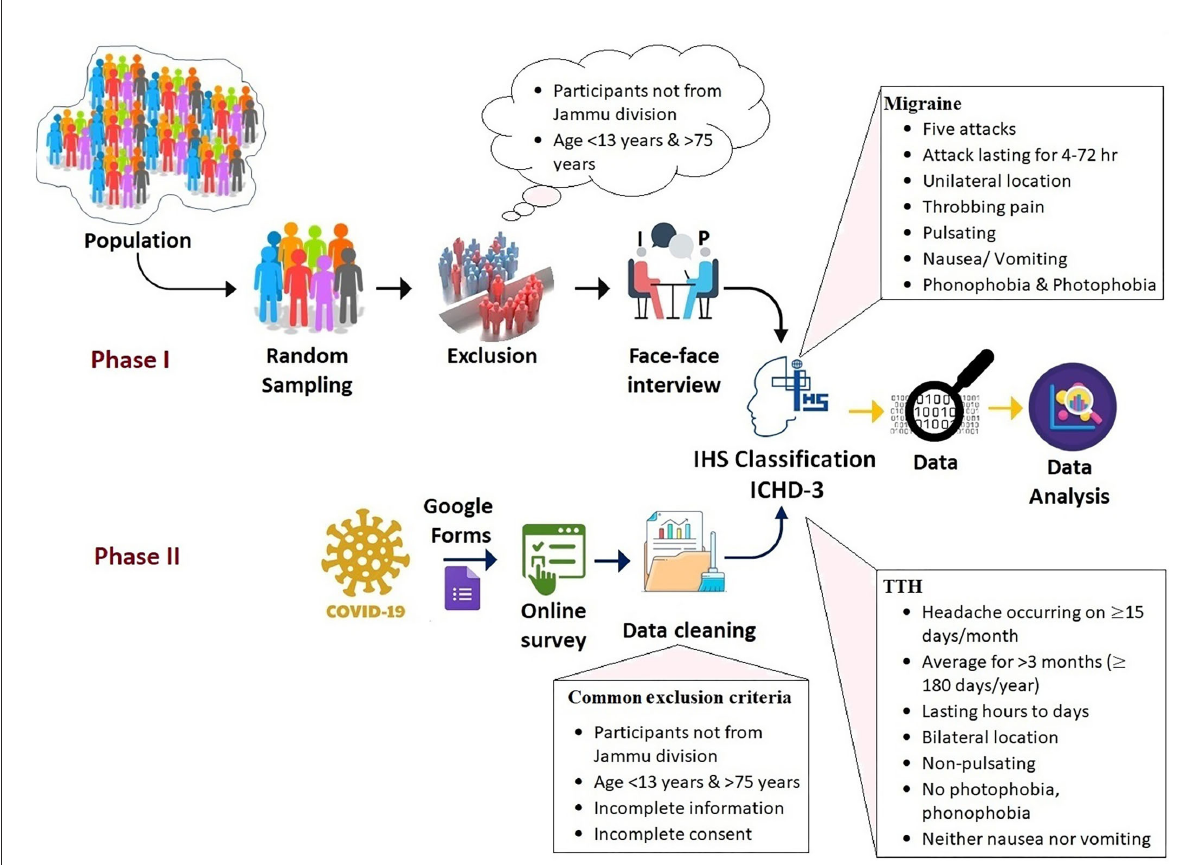
FIGURE1 Pictorial representation of the data collection in the present